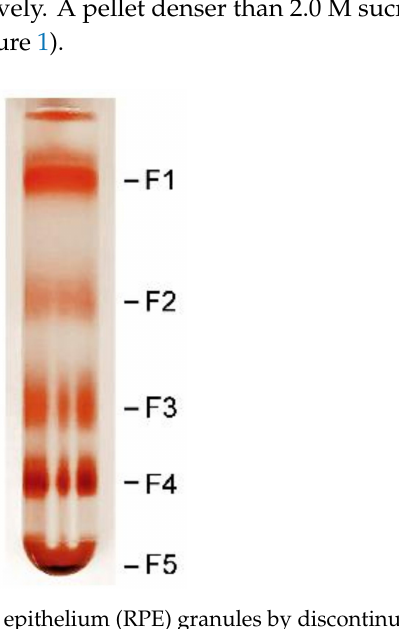
Figure 1. Fractionation of retinal pigment epithelium (RPE) granules by discontinuous sucrose